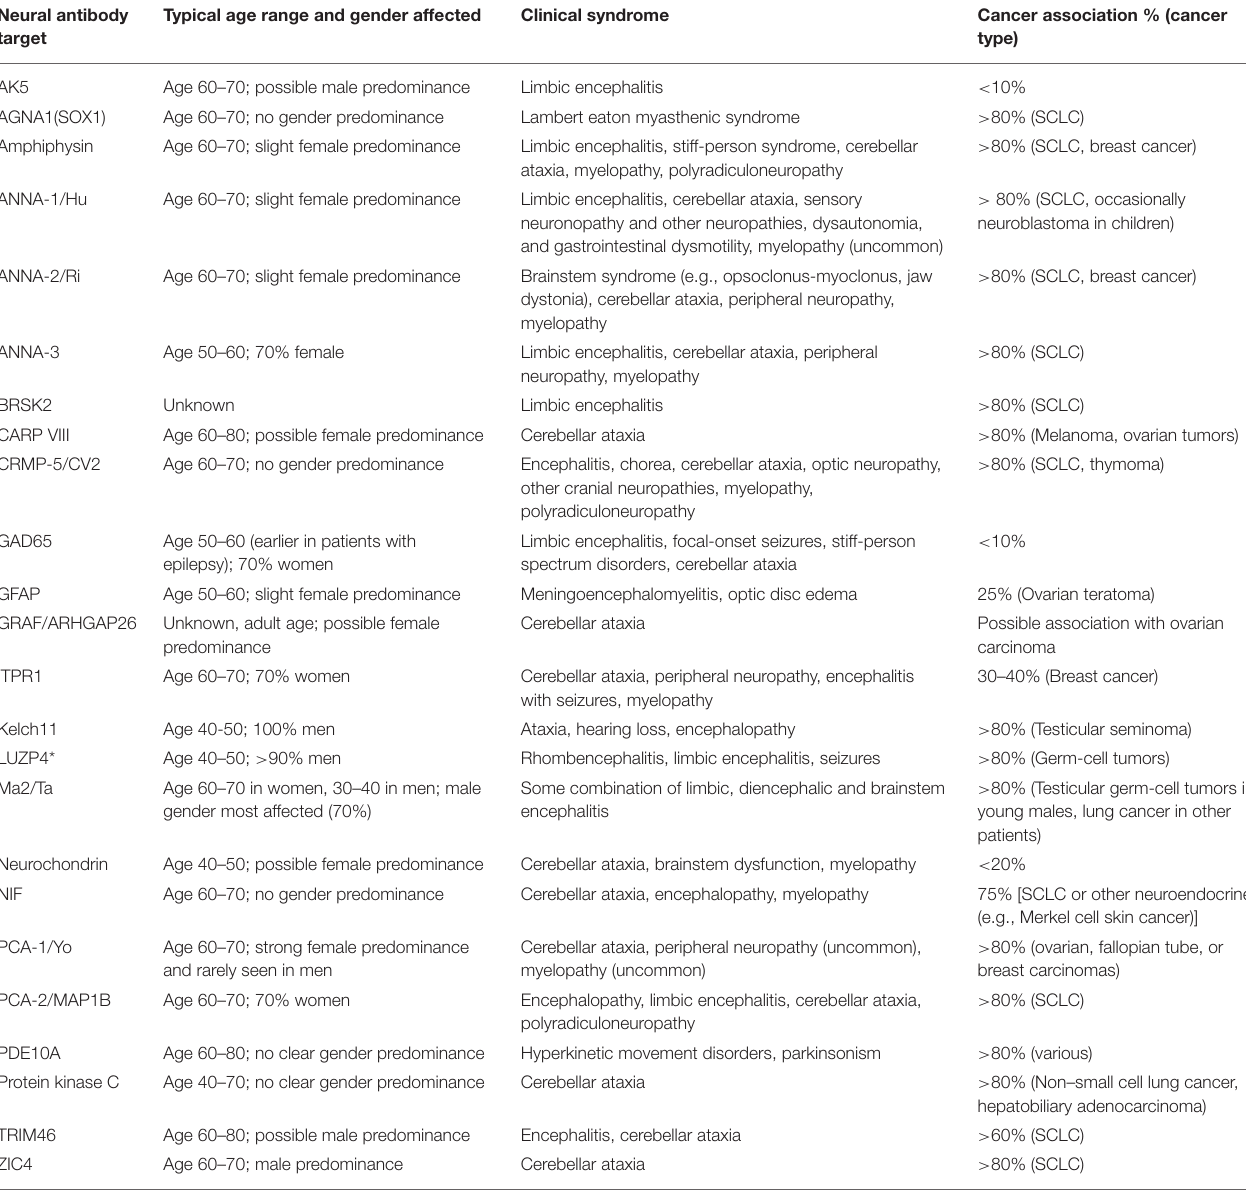
TABLE 1 | Demographic, clinical, and oncologic associations for neural autoantibodies targeting intracellular antigens. Neural antibody